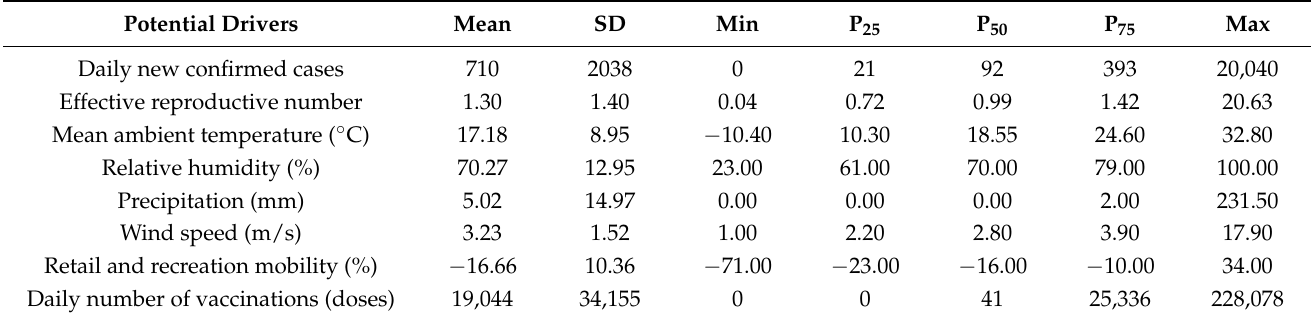
Table 1. Descriptive statistics for the number of daily new confirmed COVID-19 cases, effective repro- ductive numbers, meteorological variables, and mobility patterns across all selected six prefectures over the study